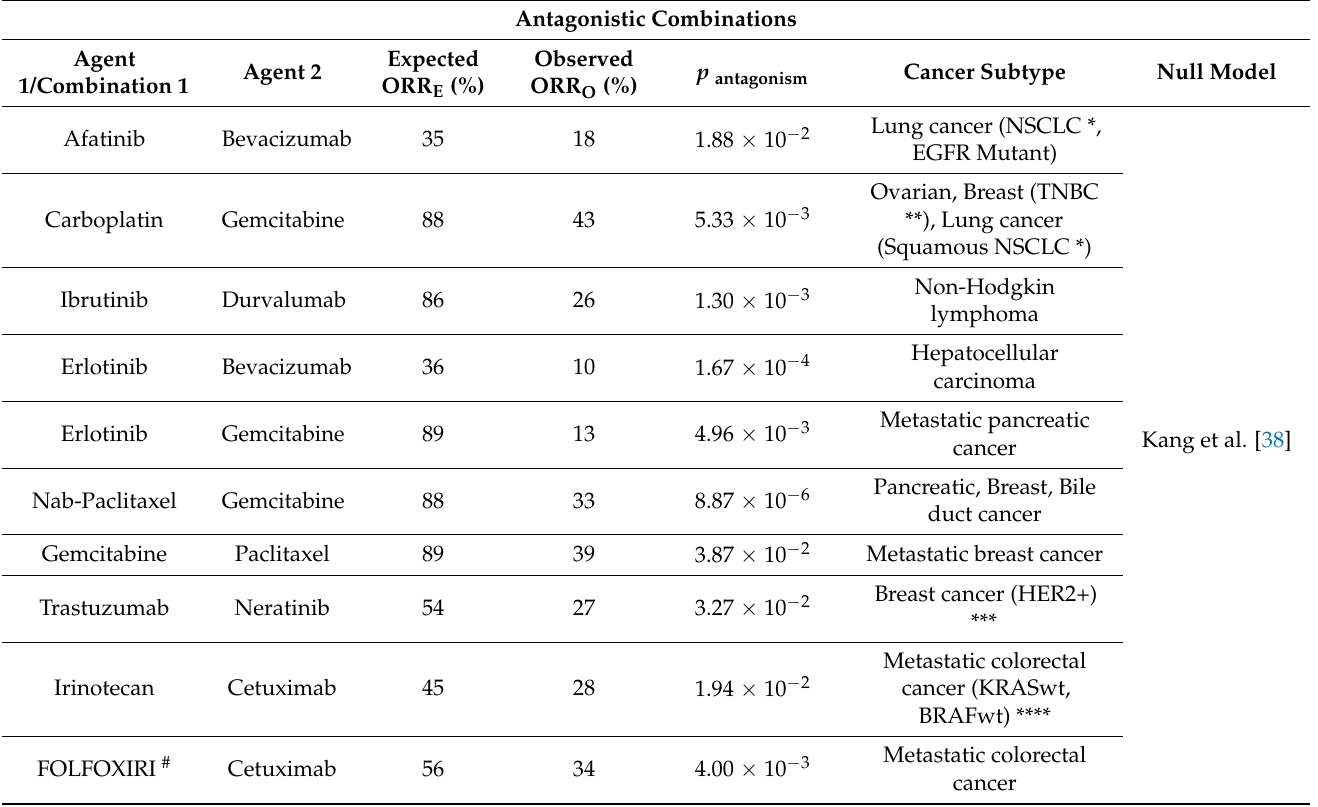
Table 3. List of inferred antagonistic